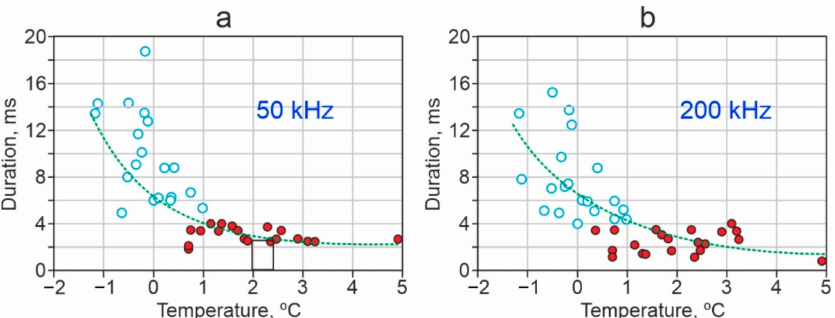
Figure 5. Temperature dependence of echo duration, 50 kHz ( a ) and 200 kHz ( b ). Open blue circles refer to stations where ultrasound penetrated anomalously deep into sediments. Dotted lines show general